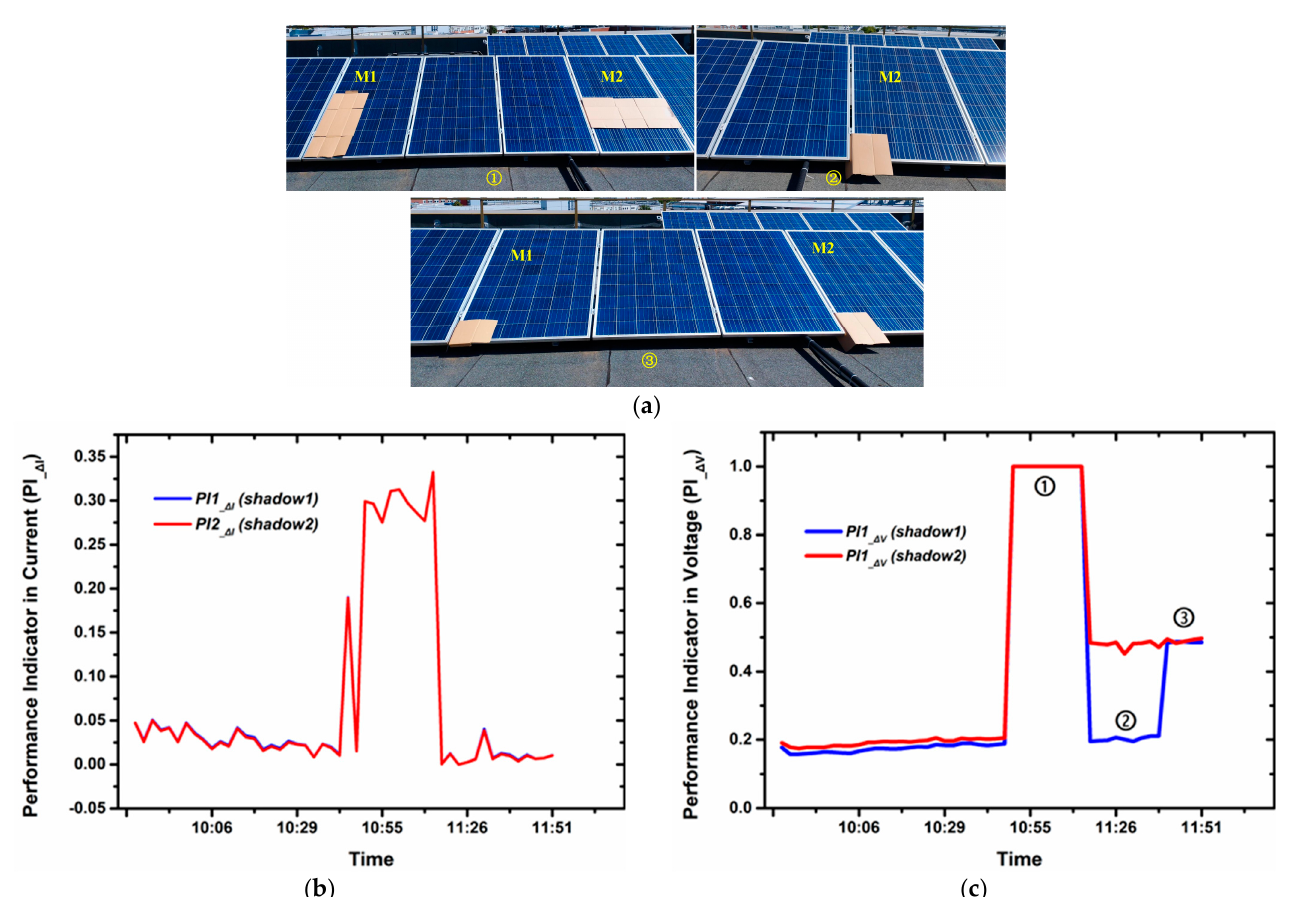
Figure 12. Performance indicators of shadow: ( a ) shadow conditions; ( b ) performance indicator in current; ( c ) performance indicator in voltage.